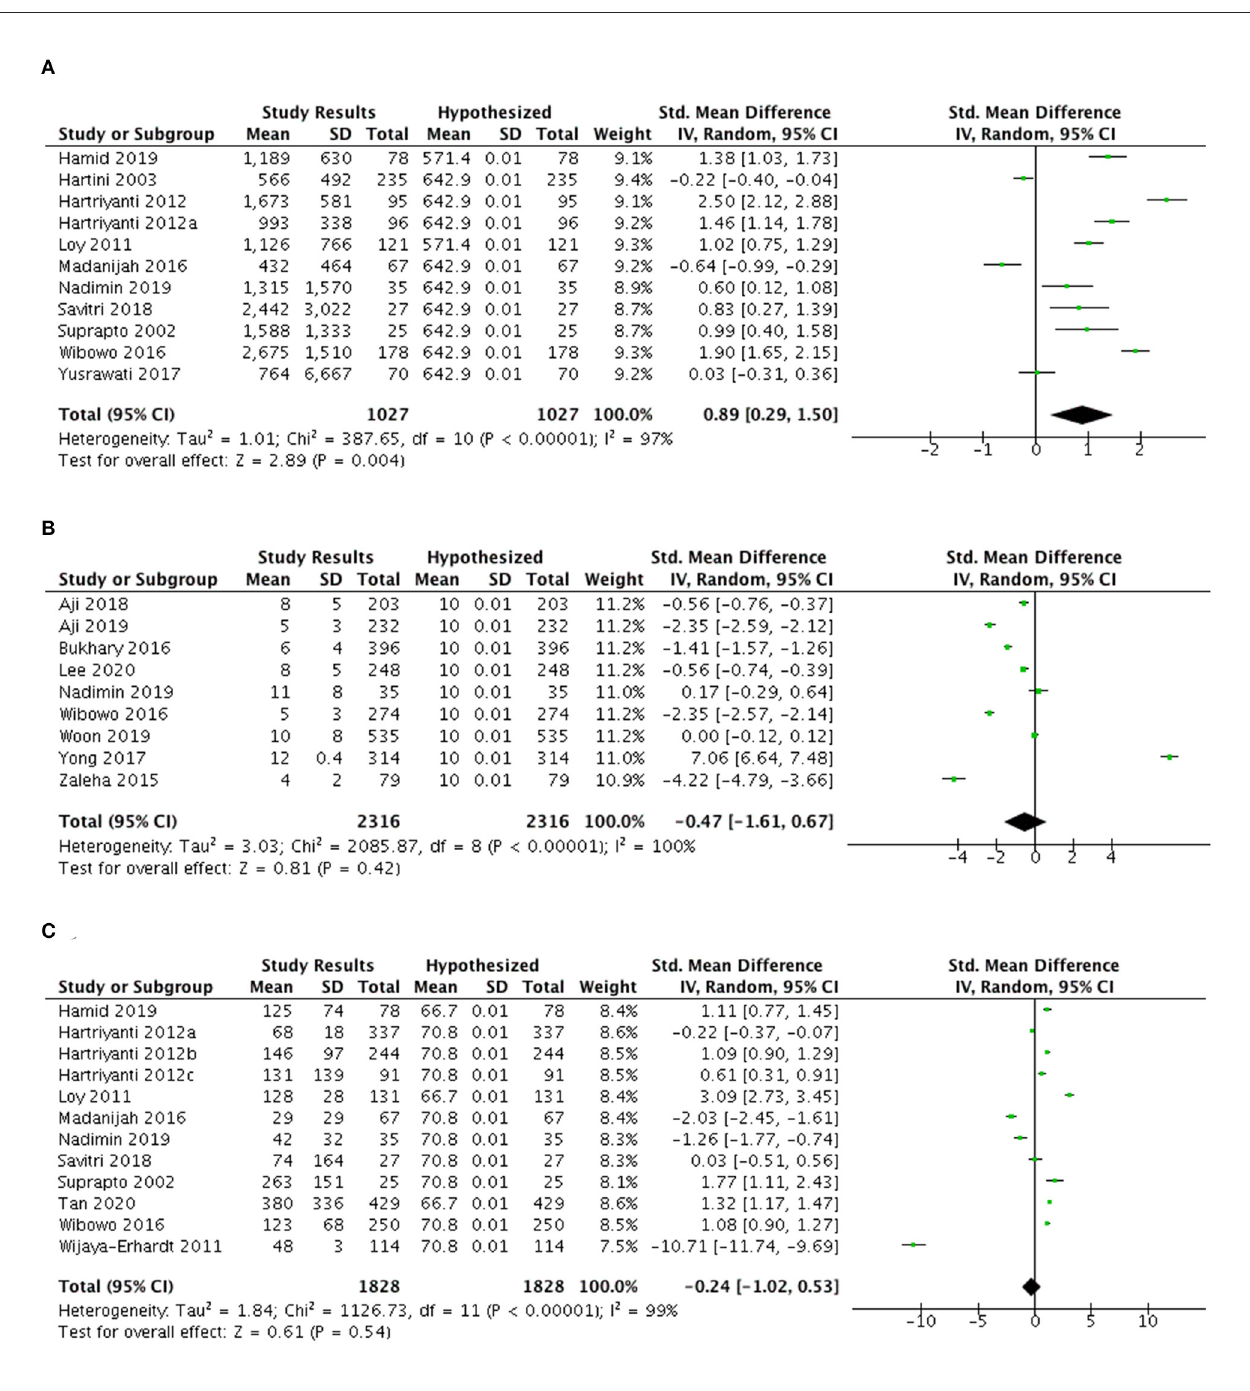
FIGURE3 (A) Meta-analysis of studies on vitamin A, (B) vitamin D, and (C) vitamin C intakes among pregnant women in Indonesia and